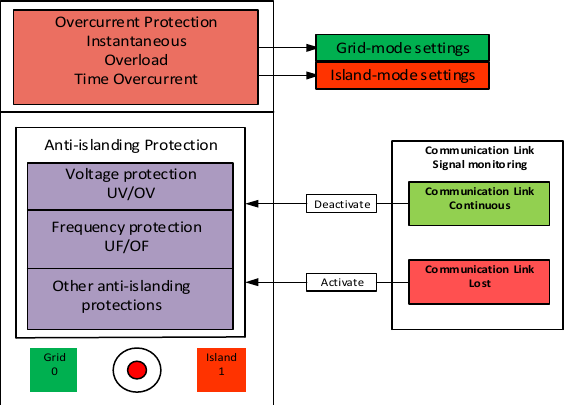
Figure 4. Amultifunctionaladaptiveintelligentelectronicdevice(IED)fortheprotectionofconverter-based Figure 4. A multifunctional adaptive intelligent electronic device (IED) for the protection of converter- distributed generators based distributed generators (DGs).